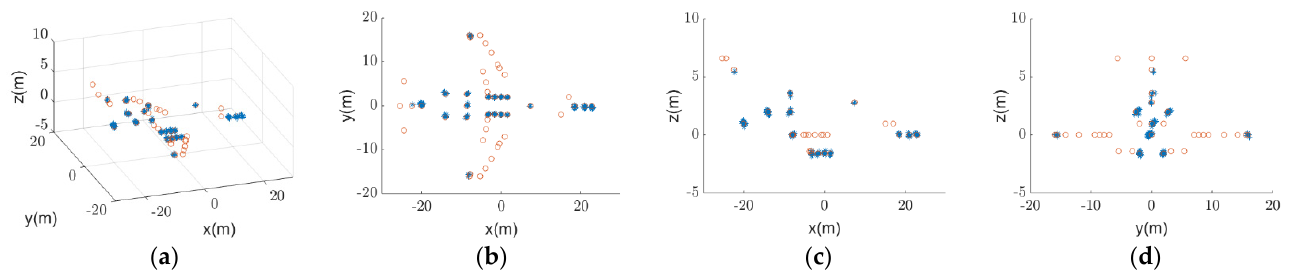
Figure 10. 3D imaging results obtained by the method in [25] with the Q scatterer at position (9.980, 9.939, 9.980) km taken as the reference scatterer in ( a ) 3D; ( b ) projection on x - y plane; ( c ) projection on x-z plane; ( d ) projection on y-z plane.